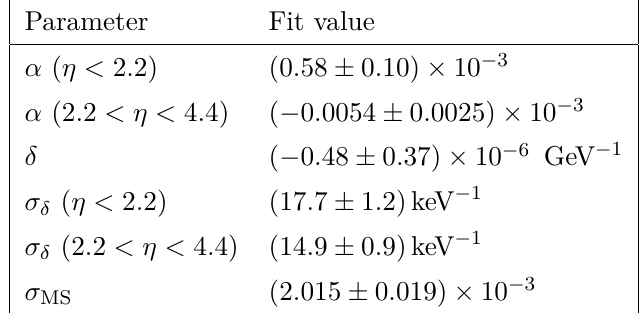
Table 1 . Parameters in the momentum smearing model where the uncertainties quoted are statis-